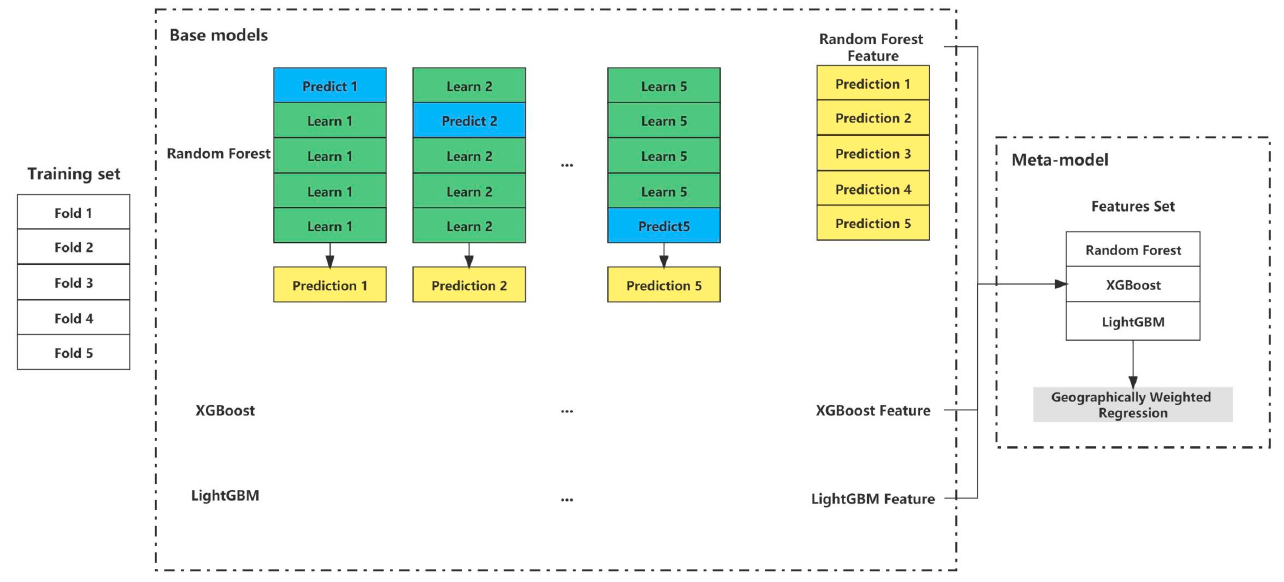
Figure 5. Procedure of stacking ensemble learning.